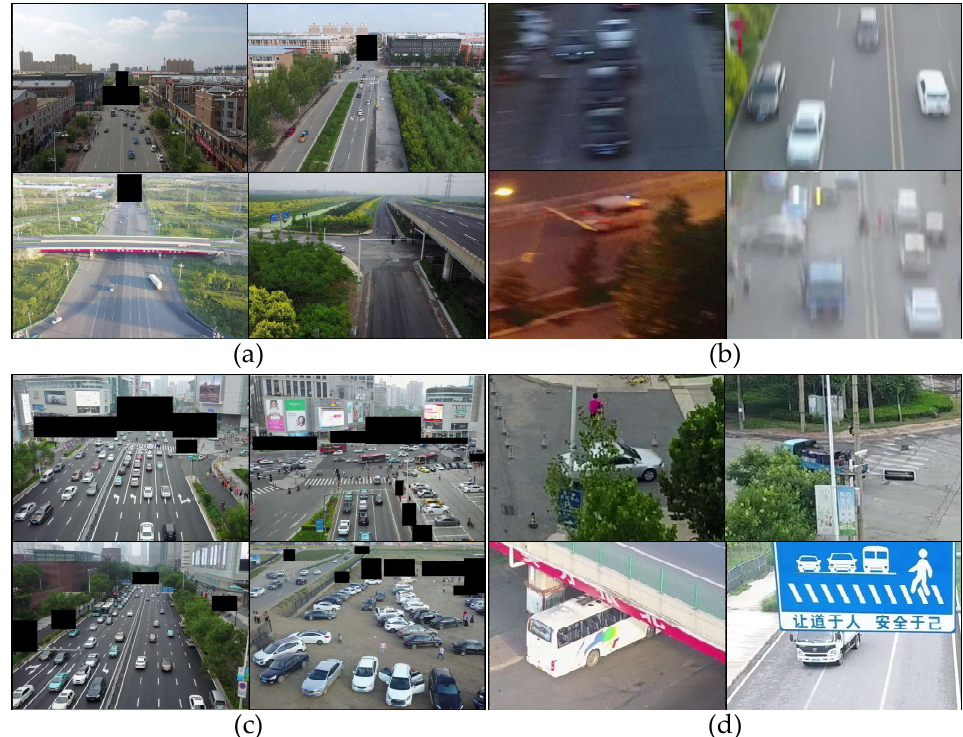
Figure 8. Hard cases of tracking in UAV videos: ( a ) small targets; ( b ) motion blur; ( c ) crowded scenarios; ( d ) occlusion.